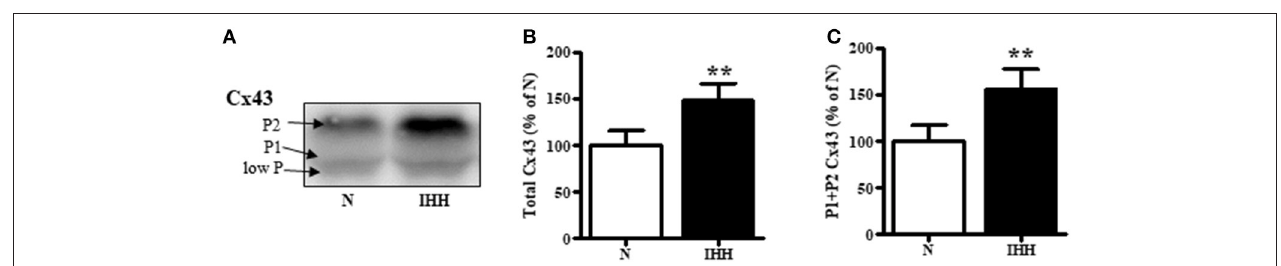
FIGURE 1 | Effect of chronic intermittent hypobaric hypoxia (IHH, black columns) on expression of total Cx43 (B) and its high-phosphorylated forms (P1 + P2 Cx43) (C) compared with normoxic group (N, open columns). The representative image of western blotting is shown (A) . Values are mean ± SEM, ( n = 5 in each group), ** p <